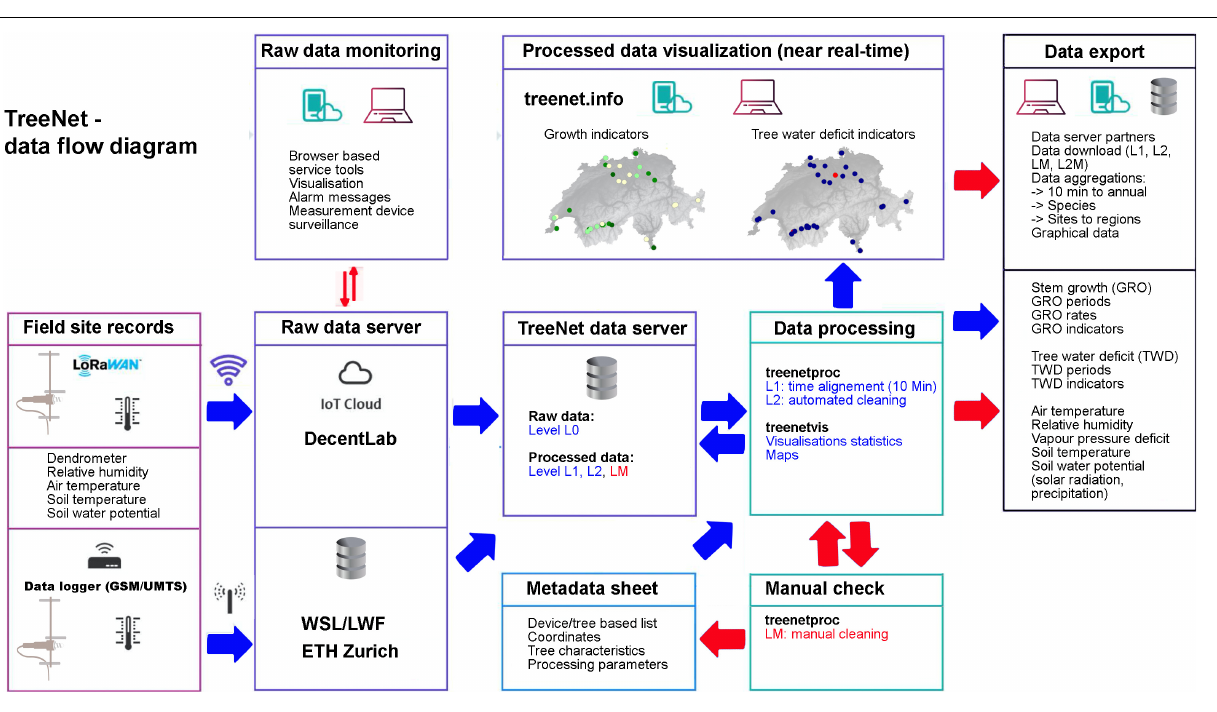
FIGURE 3 | TreeNet data flow diagram from measurement devices in the field to the processed data products, i.e., automated data visualization in the online interface (www.treenet.info) and data output. Blue arrows indicate automated data transfer, red arrows indicate user-initiated data